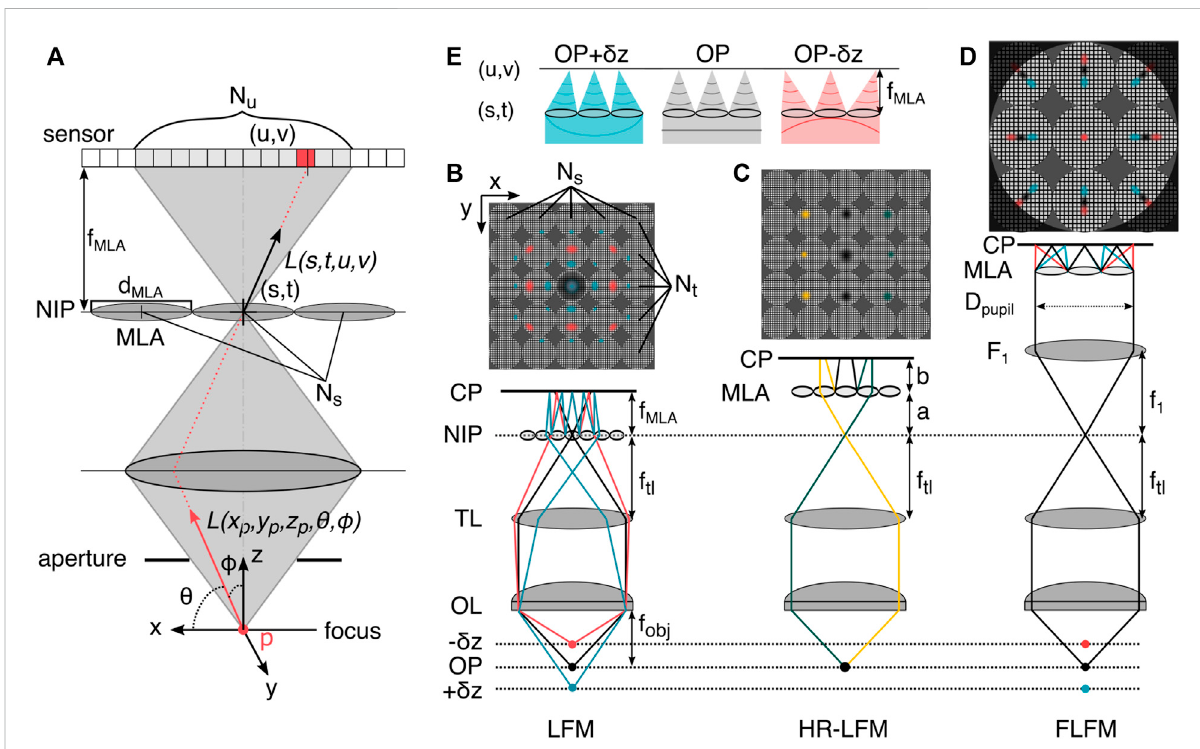
FIGURE 5 The plenoptic function and light fi eld microscopy. (A) In three-dimensional space, the plenoptic function is fi ve-dimensional. Its rays can be parametrized by three spatial coordinates and two angles. In the absence of occluders, the function becomes four-dimensional. Shown is the light slabparametrization by pairsof intersections between two planes, here atamicrolens inthe NIP (s,t) and inthe sensor plane with pixels (u,v). (B) LFM prototype con fi guration [58], the microlens array (MLA) is placed in the native image plane (NIP), and the sensor is placed at the camera plane (CP) behind this, positioned so that each microlens records an in-focus image of the objective (rays not shown). The MLA consists of N s × N t lenses with diameter d MLA /2. On the sensor, N u × N v pixels are mapped to the lenses. (C) High-resolution light fi eld microscopy (HR-LFM) con fi guration [9] with the MLA positioned to form a defocused image, with its location de fi ned by the distances a (to the NIP) and b (to the CP). As in other LFM methods, rays propagating in different directions (green and yellow) are mapped onto to different camera pixels, allowing the reconstruction of perspective views of the object. (D) Fourier light fi eld microscopy (FLFM) con fi guration [56, 60]. The objective lens (OL) and tube lens (TL) form an image at the NIP. The Fourier lens ( F 1 ) transforms the image at the NIP to the back focal plane of the FL, where the MLA is situated. The light- fi eld information is recorded by the camera at the back focal plane of the MLA. Identi fi cation of the emitter in multiple subimages and subsequent axial information recovery from the radial position in the subimages enables volumetric single-molecule imaging. (E) The microlens array in FLFM (D) samples spatial and angular information from the wavefront, indicated by a colored line below the MLA, which exhibits asymmetric curvature about the primary image plane. Hence, z-displaced emitters are mapped to different positions in the perspective view. OP: object plane, f: focal